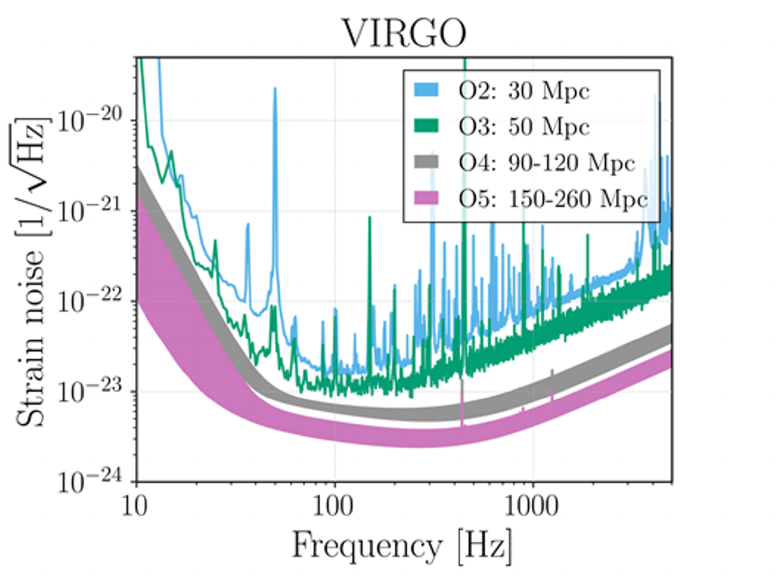
Figure 13. The evolution of the Advanced Virgo sensitivity in the past two Observing Runs, and the expected sensitivity for the next two. Advanced Virgo Plus Phase I will run in O4, while the Phase II upgrades will be implemented between O4 and O5. Figure from [145]: © The Authors, published by Springer Nature. This is an open access article distributed under the terms of the Creative Commons Attribution License 4.0 (http://creativecommons.org/licenses/by/4.0/ (accessed on 10 August